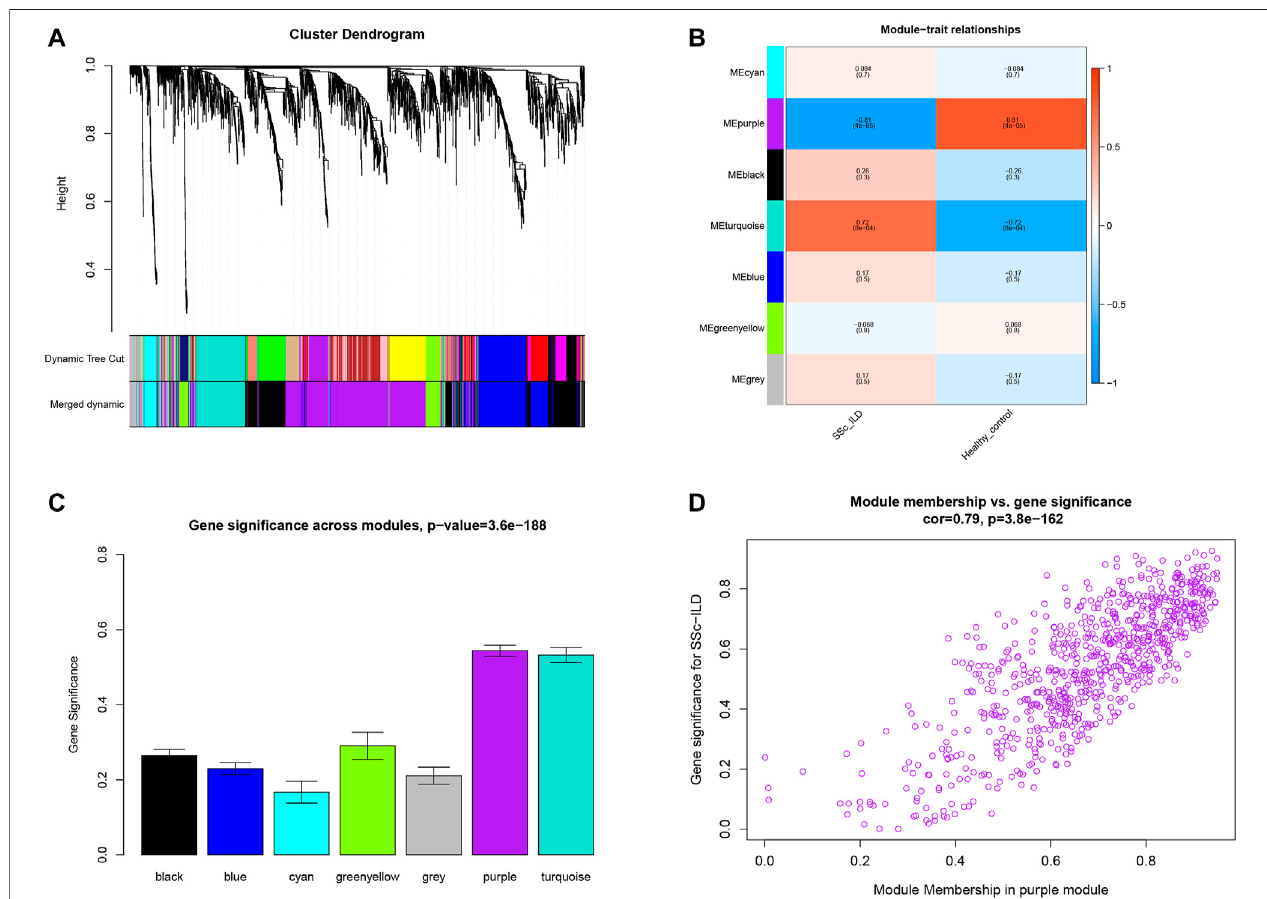
FIGURE 1 | (A) Clustering dendrogram of genes which coef fi cient of variation > 7% associated with systemic sclerosis-related interstitial lung disease (SSc-ILD) in GSE76808. (B) Heatmap of module-trait relationships revealed by WGCNA analysis. (C) Distribution of average gene signi fi cance and errors in the modules related to SSc-ILD. (D) The gene signi fi cance for SSc-ILD in the purple module (one dot represents one gene in the purple module).